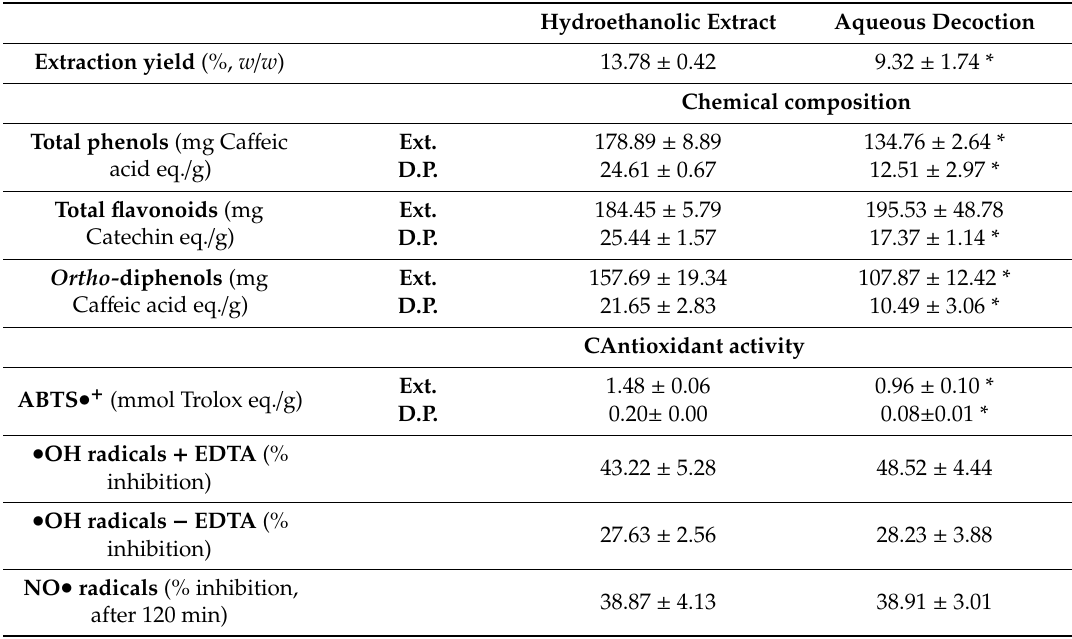
Table 1. Extraction yields, chemical composition, and antioxidant activity of extracts obtained from Thymus mastichina